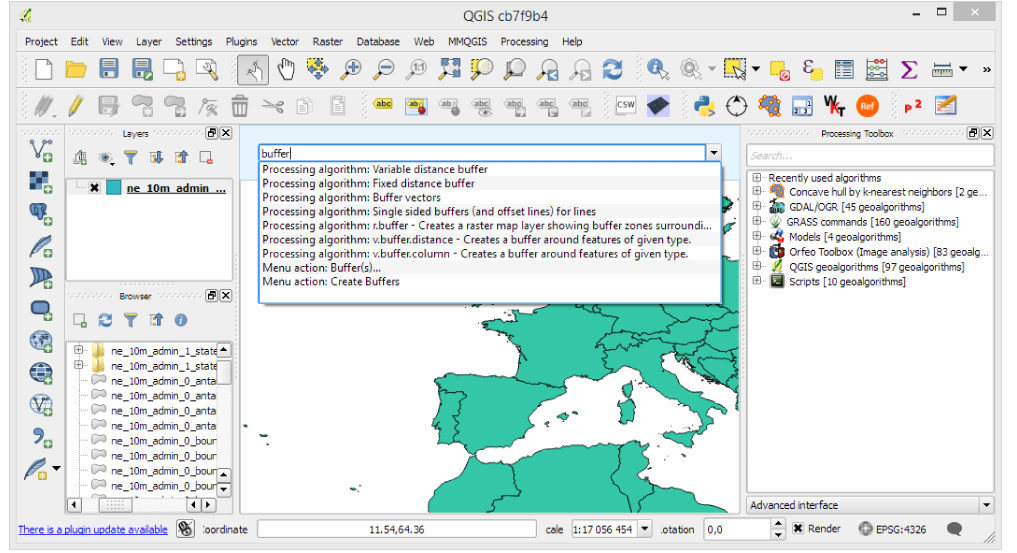
Figure 5. Processing Toolbox (right panel) and Commander with auto-complete (top